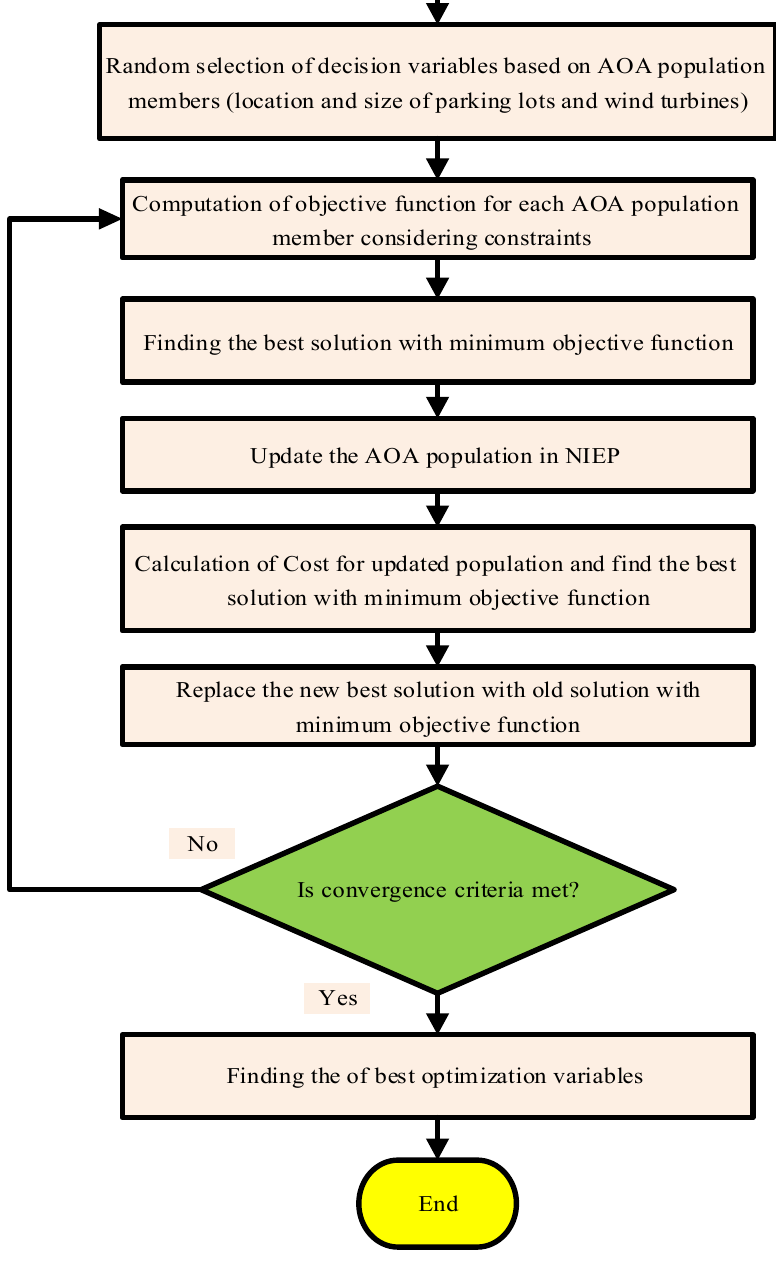
Figure 3. The OSPF for parking lots and wind turbines via AOA in the distribution network.